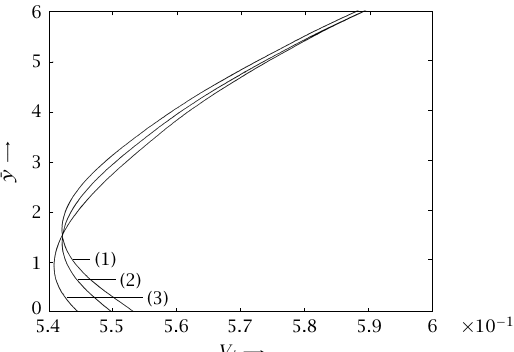
Figure 4.10 . Transverse velocity component of the fluid V i in the boundary layer for R = 500, 4 = 0 . 05, t = 1. (1) X = − 0 . 5, λ = 0 . 01, (2) X = − 0 . 5, λ = 0 . 36, (3) X = − 0 . 5, λ = 0 .